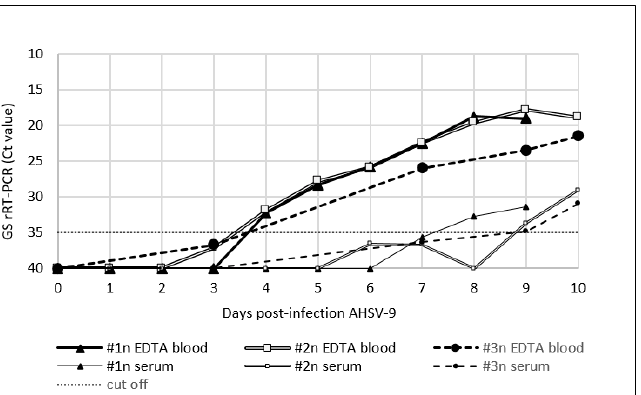
Figure 3. Comparation of RNAemia (GS rRT-PCR) in EDTA blood and serum samples in naïve horses experimental infected (#1n, #2n and #3n).